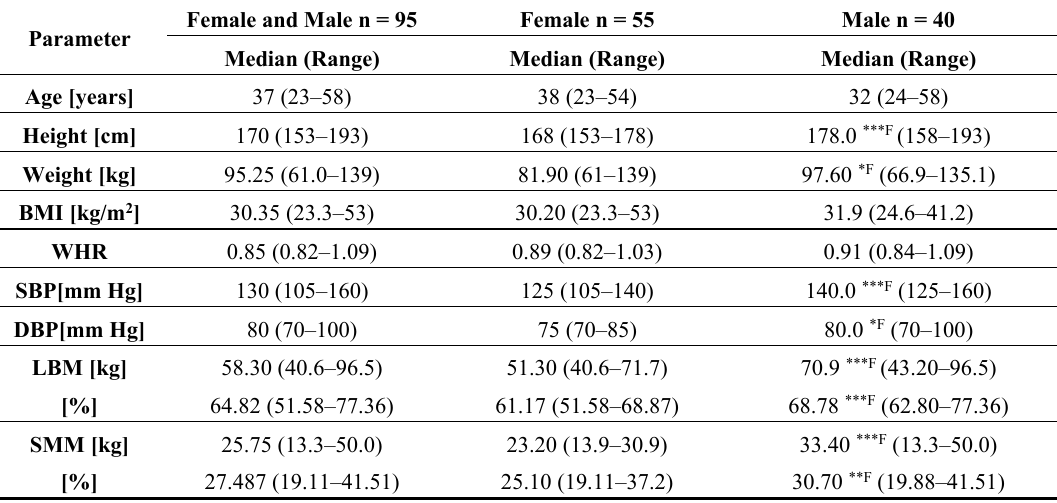
Table 1. Anthropomorphic parameters in the study group, by